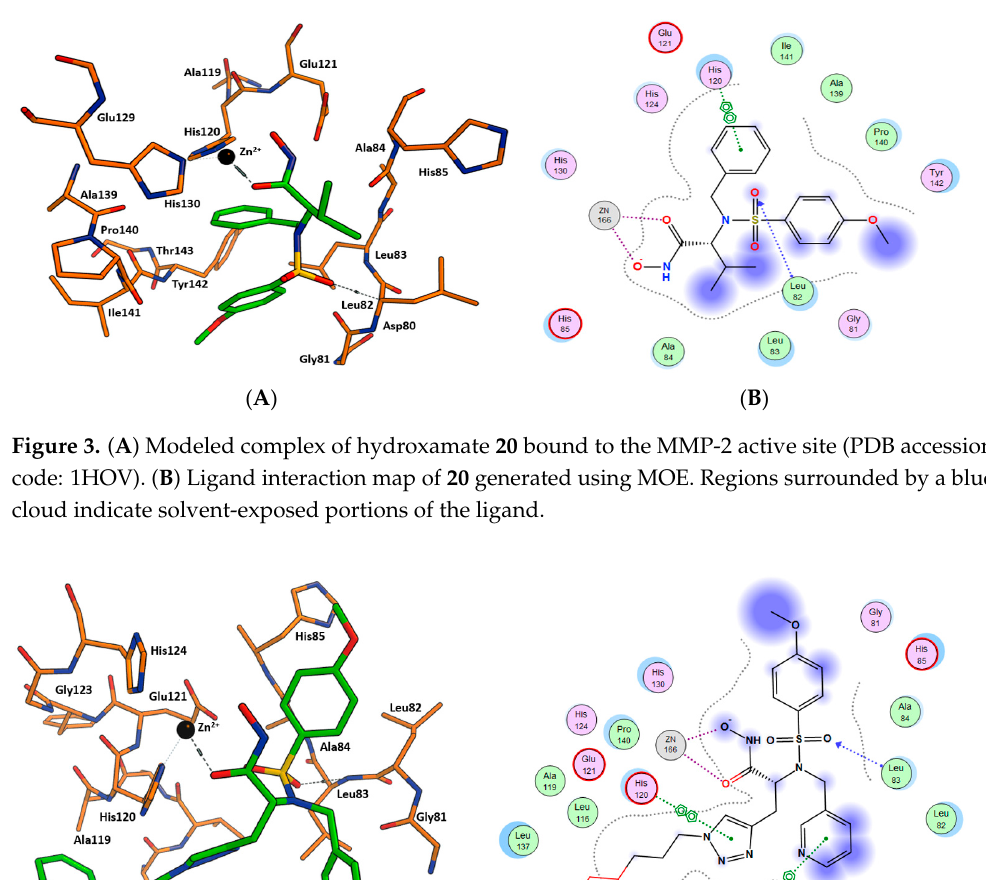
Figure 5. Cell toxicity, IC 50 (moles/liter), i.e., the concentration at which it inhibited the growth of SCC VII cells by 50% after 3 day of continuous exposure, was determined via CellTiter 96 ® Aqueous One Solution Cell Proliferation Assay. 2.4.2. Evaluation of SC-78080/SC-77964 Analogs 1 ( B1 ) and 2 ( B2 ) for BNCT E ffi cacy BNCT e ffi cacy is demonstrated in SCC VII cells (Figure 6) and in U87 glioma cells (Figure 7). The survival fraction of 1 ( B1 ) and 2 ( B2 ) in a pre-incubation boron concentra- tion at 0.143 ppm 10 B and 0.101 ppm 10 B, respectively, were similar (Figure 6). The IC 50 values of 1 and 2 ( B1 and B2 ) were determined to be 2.04 × 10 − 2 mg/mL and 2.67 × 10 − 2 1